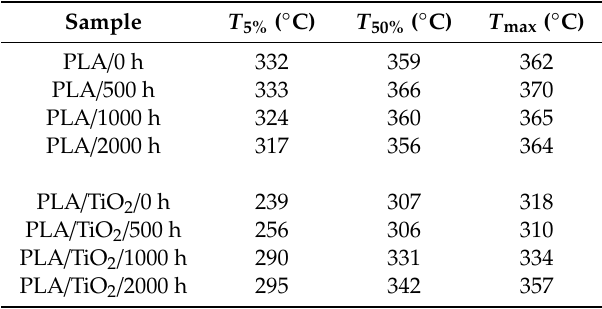
Figure 14. Di ff erential TGA curves for the ( a ) PLA and ( b ) PLA / TiO 2 samples after di ff erent periods of Figure 14. Differential TGA curves for the ( a ) PLA and ( b ) PLA/TiO 2 samples after different periods accelerated weathering. of accelerated weathering. Table 4. Characteristic degradation temperatures for PLA and the PLA / TiO 2 samples obtained from the TGA and dTGA curves in Figures 13 and Table 4. Characteristic degradation temperatures for PLA and the PLA/TiO 2 samples obtained from the TGA and dTGA curves in Figures 13 and 14.